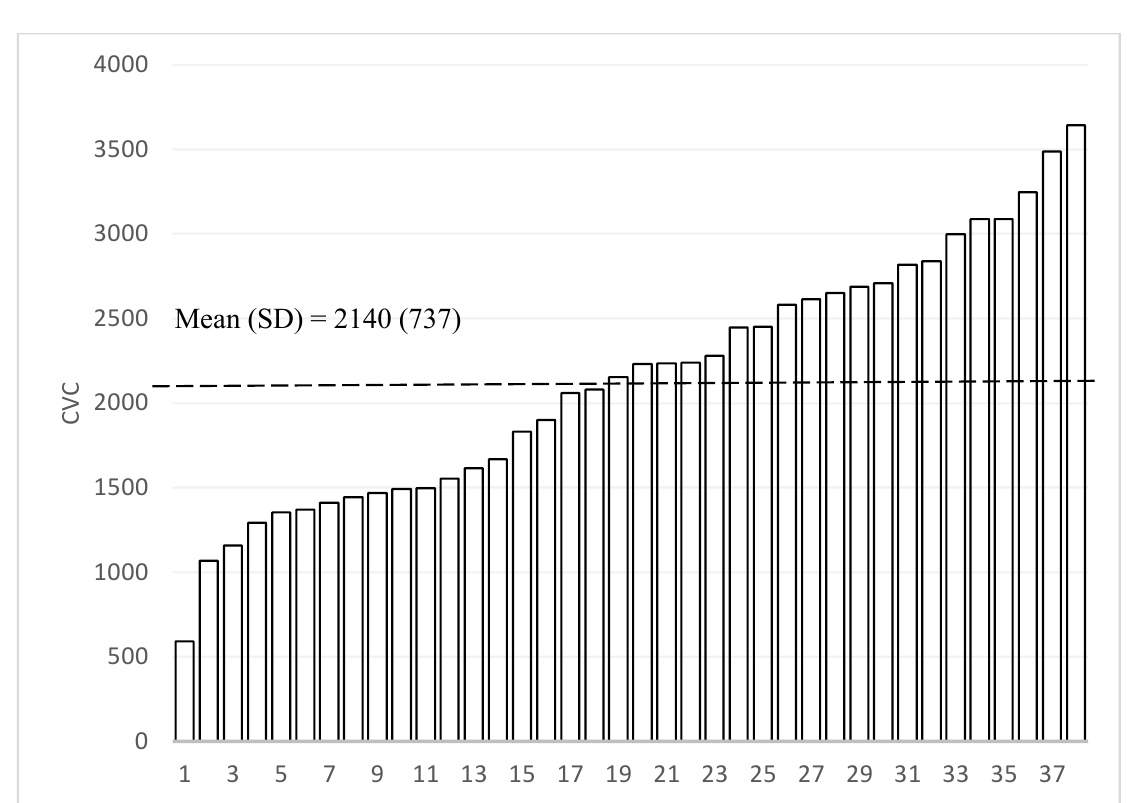
Figure 4. Distribution of Child Vocalization Count (CVC, N = 38). “SD” is defined as standard deviation.